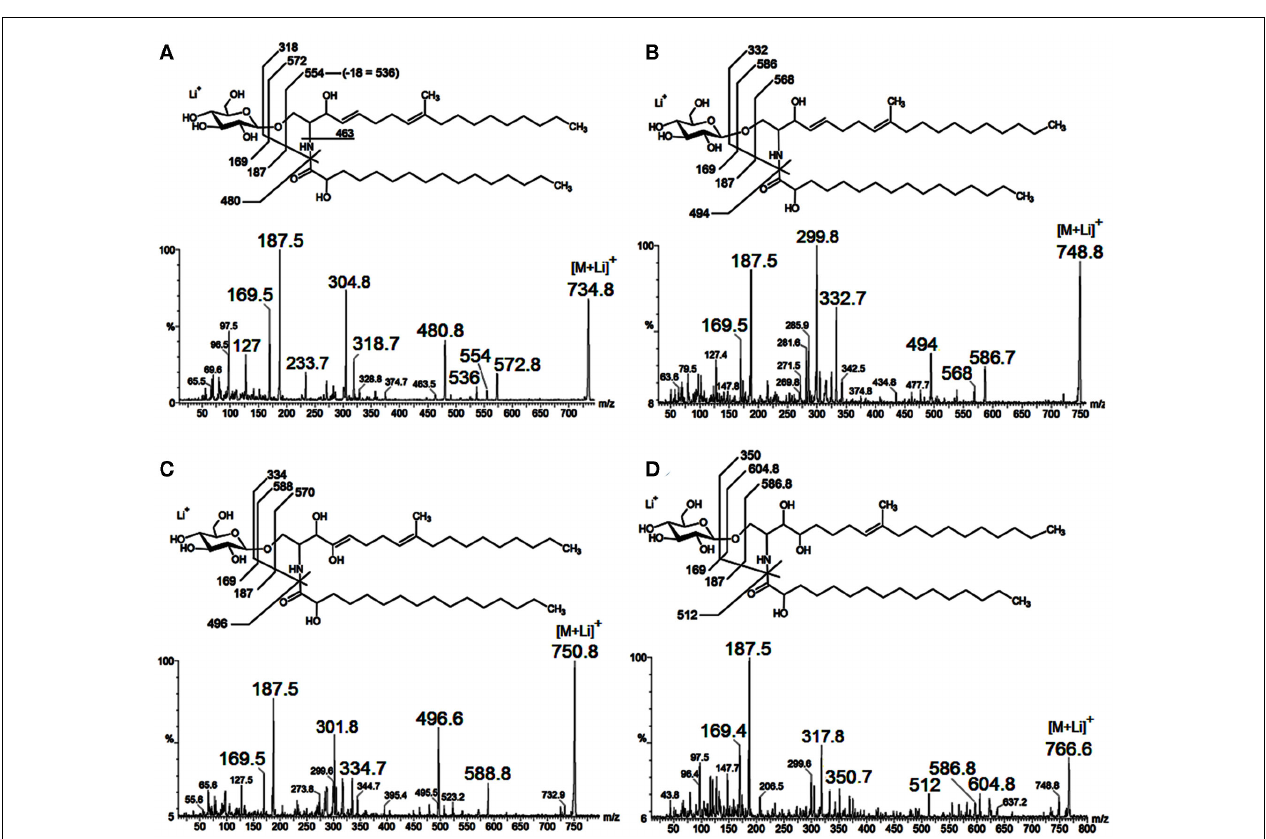
FIGURE 6 | Characteristic tandem-MS profiles obtained from lithiated CMHs from Scedosporium apiospermum (A,C) and Cladosporium